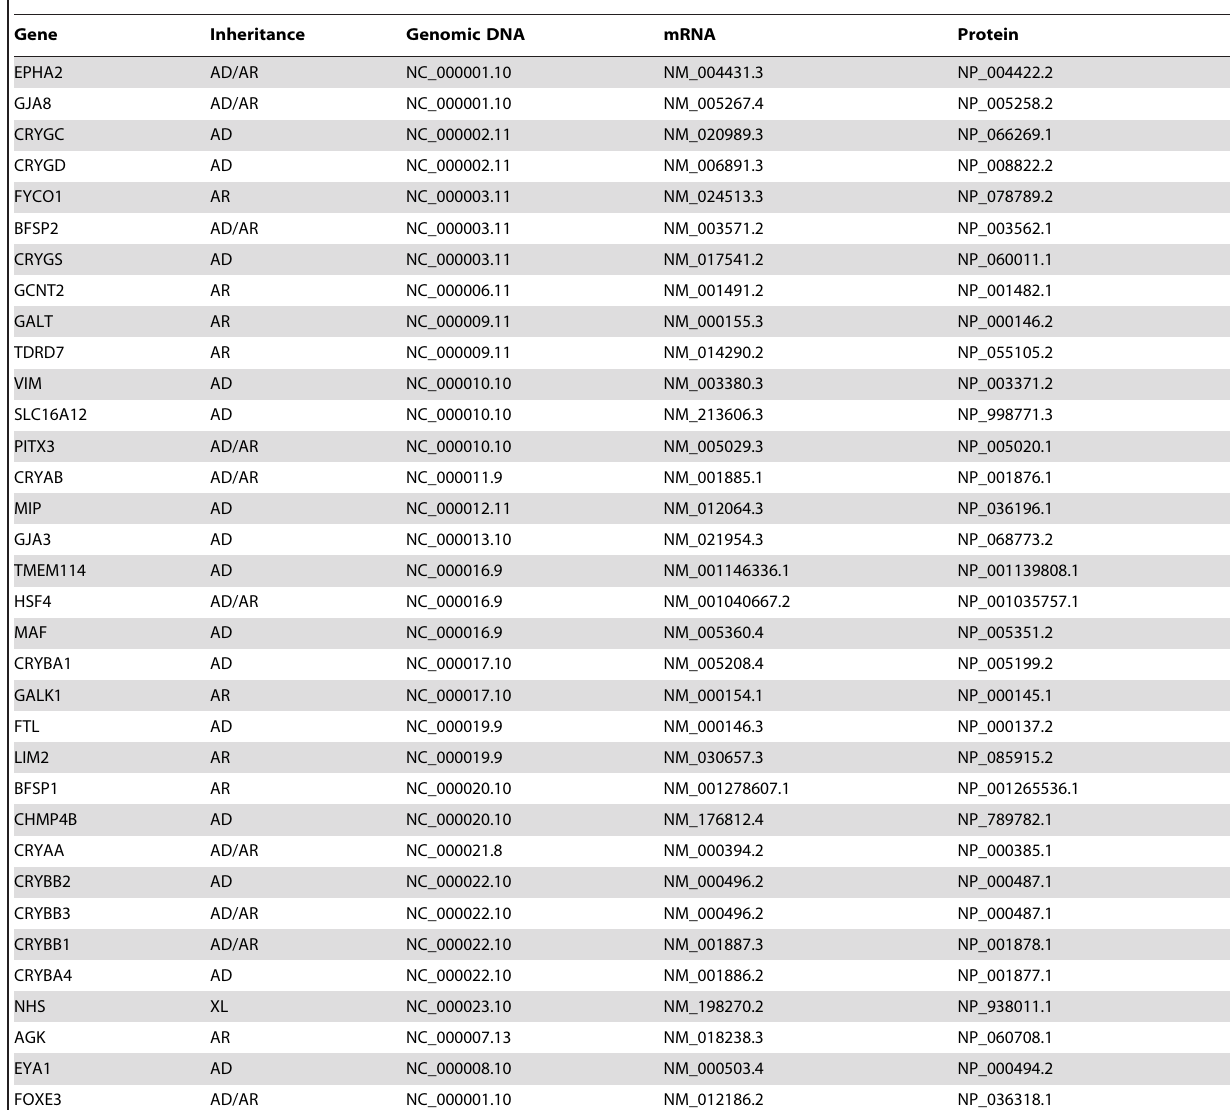
Table 1. Information of the 34 genes referred in this